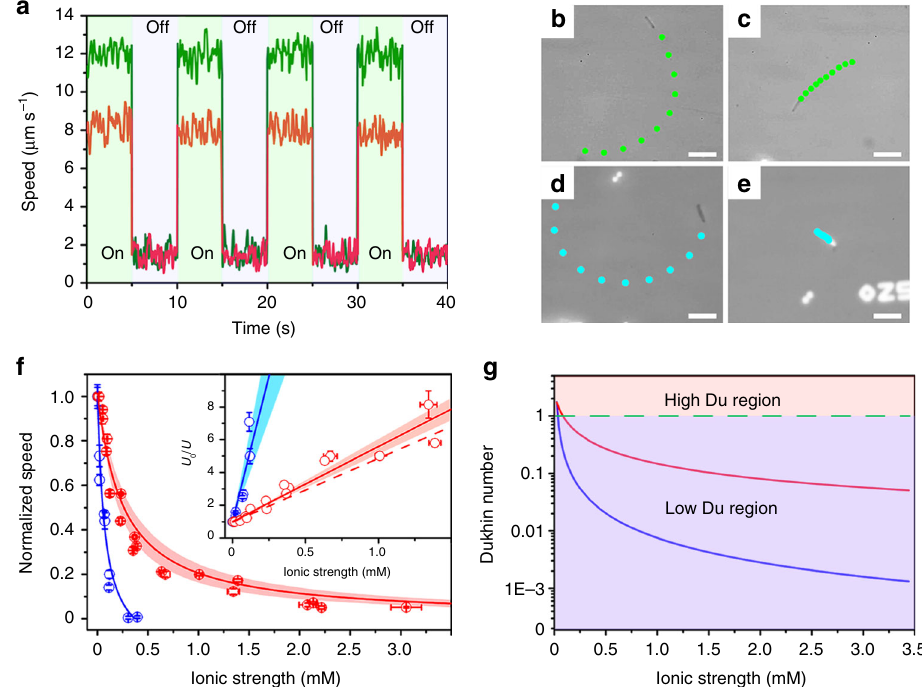
Fig. 3 Ion tolerance enhancement for silicon nanowire microswimmer. a A typical migration speed of microswimmer with and without SPS coating in BQ/ H 2 Q solution under chopped illumination. Microswimmer ’ s trajectory in BQ/H 2 Q solution: the SPS coated without ( b ) and with ( c ) 0.32 mM NaCl; bare without ( d ) and with ( e ) 0.32 mM NaCl. Scale bar is 20 μ m. f The dependence of the normalized speed of the bare (blue) and the SPS coated (red) nanowire microswimmer to the solution ionic strength and the corresponding speed is shown in Supplementary Figs. 12 and 13. The solid lines are calculated by our proposed model with measured conductivity, and the band is at 95% con fi dence interval. The inset shows the linear relationship between C . The red dash line in the inset is predicted by our model while the solid the normalized reciprocal speed and the electrolyte concentration as U 0 U ¼ 1 þ 1 EI 50 lines and corresponding color bands indicate the fi tting plots and a con fi dence interval at 95%. g The Dukhin number vs. ionic-strength plot for bare microswimmer (blue line) and SPS-coated microswimmer (red